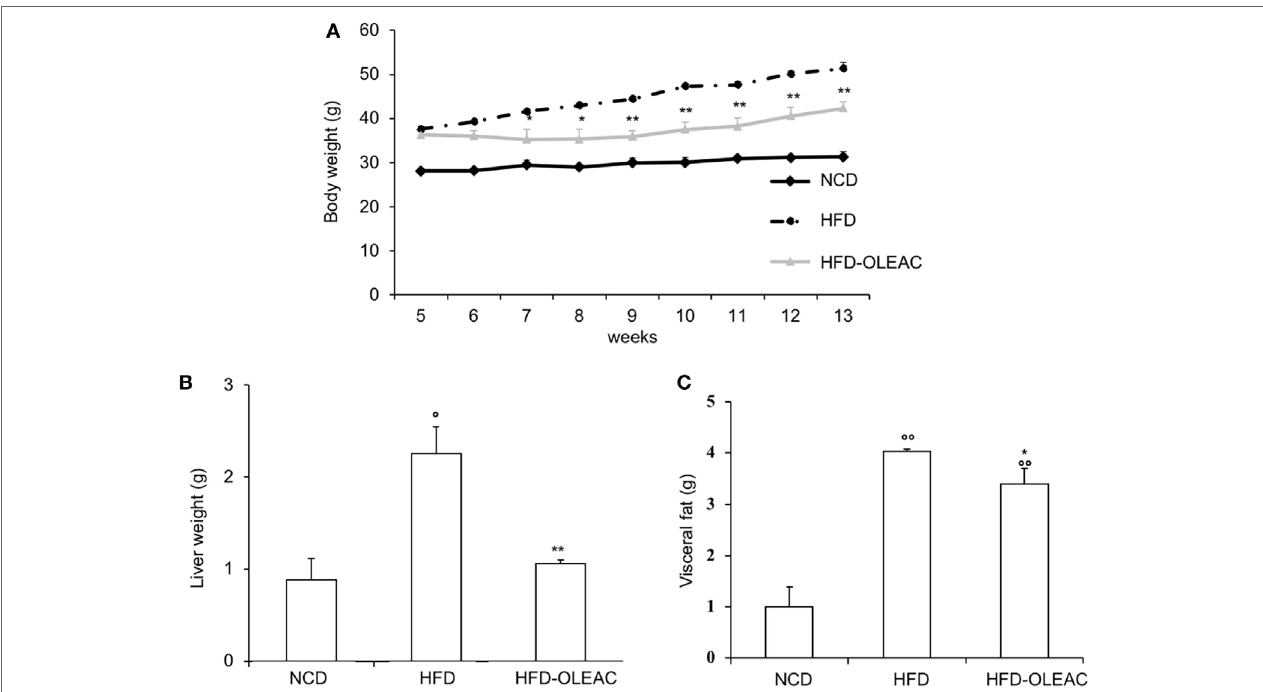
FigUre 6 | Effects of oleacein on body weight, visceral fat, and liver weight in obese mice fed with high-fat diet (HFD). Body weight (a) , liver weight (B) , and visceral fat (c) were measured in obese mice fed with HFD. Values are expressed as mean ± SD. * p < 0.05, ** p < 0.01 vs HFD. ° p < 0.05, °° p < 0.01 vs mice fed with NCD. HFD-OLEAC, mice treated with oleacein.